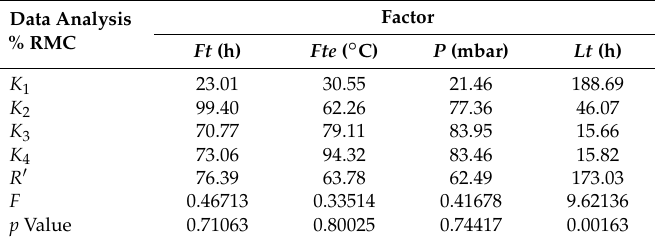
Table 3. Data analysis of dried Mexican kefir grain (MKG) residual moisture content (% RMC).